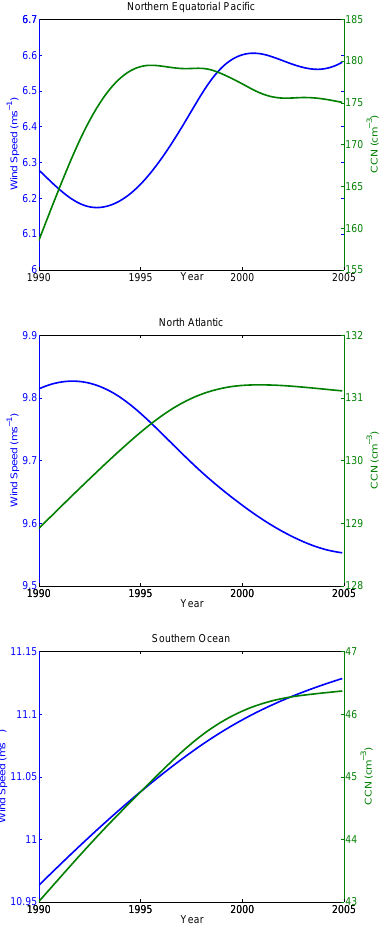
Figure 3. Trends in wind speed (blue lines) and CCN concentrations (green lines) in (a) the Northern Equatorial Pacific, (b) the North Atlantic, and (c) the Southern